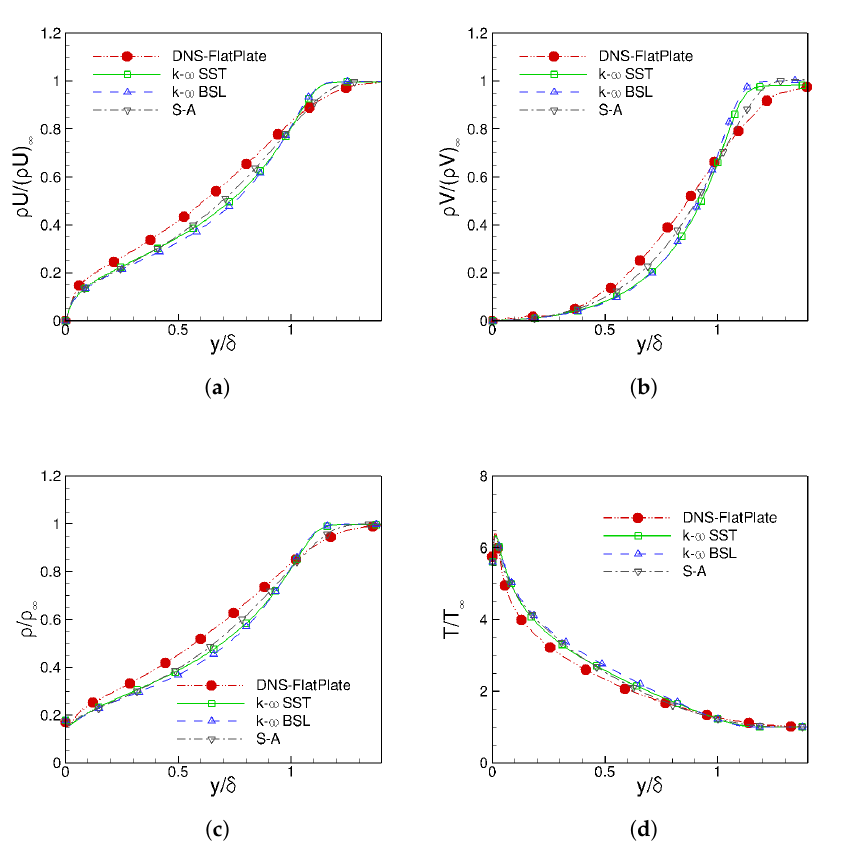
Figure 5. Comparison of mean boundary-layer profiles at Re τ ≈ 500 between RANS and DNS. ( a ) Mean streamwise mass flux ρ U ; ( b ) mean wall-normal mass flux ρ V ; ( c ) mean density ρ ; ( d ) mean temperature T